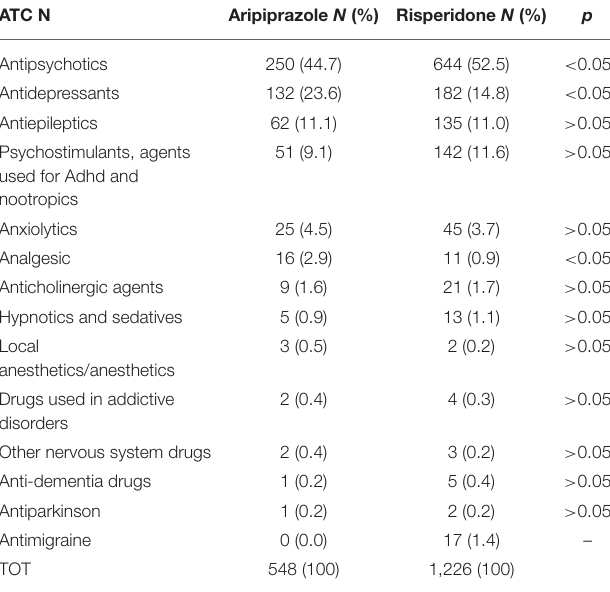
TABLE 8 | Distribution of other suspected drugs reported with aripiprazole and risperidone belonging to the Anatomical Therapeutic Chemical (ATC) N group third level: Drugs acting on nervous system.